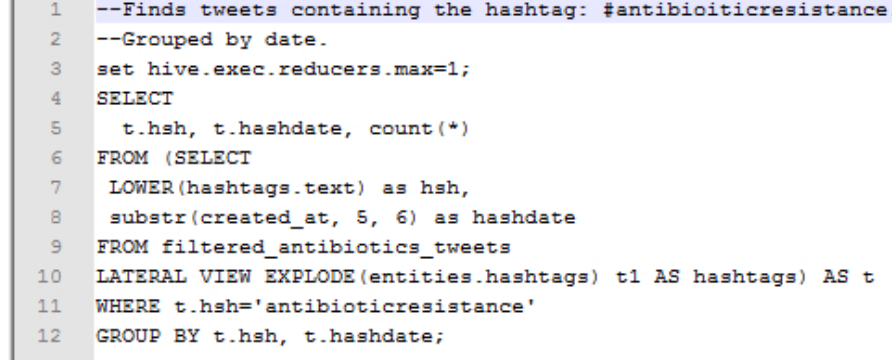
Figure 2. HiveQL query to determine the number of tweets containing "#antibioticresistance", sorted by